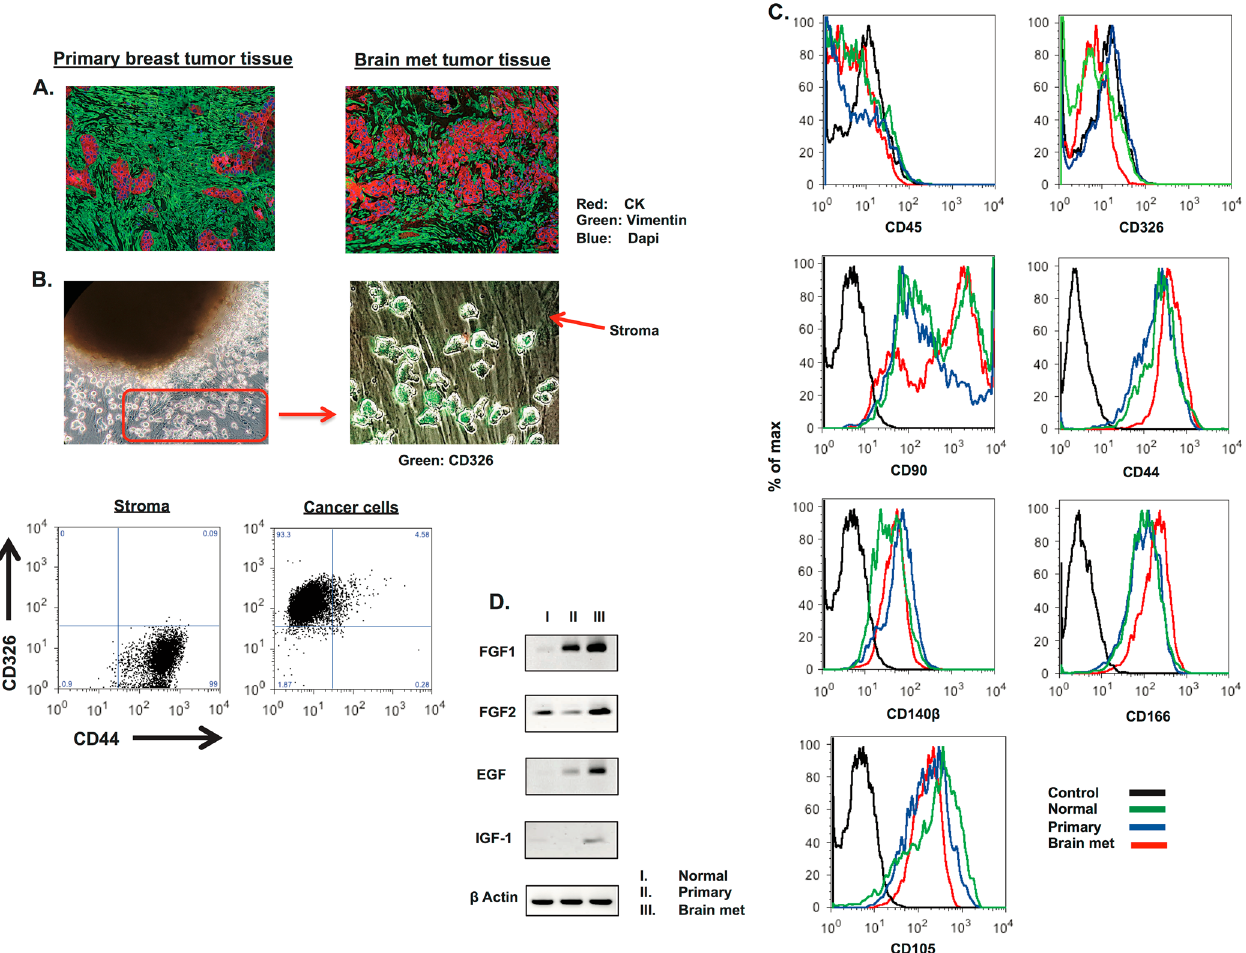
Fig. 1 Characterization of fi broblasts isolated from primary and brain met breast tumor in culture. a Immunohistochemistry was performed to determine the prevalence of CAFs (vimentin+) surrounding breast cancer cells (CK+). b Morphology of CAFs (CAS) and breast cancer cells growing in tissue culture, 2 weeks after plating human breast tumor fragments ( green color represents CD326+ cancer cells and a red arrow indicates CD44+ CD326- fi broblasts. c At 2 – 4 weeks, normal human breast fi broblast, primary CAS, and brain met CAS surface marker expression was analyzed by FACS. d Gel electrophoresis RT PCR data demonstrates relative growth factor expression of FGF-1, FGF-2, EGF, and IGF-1 in normal, primary and metastatic aggregate